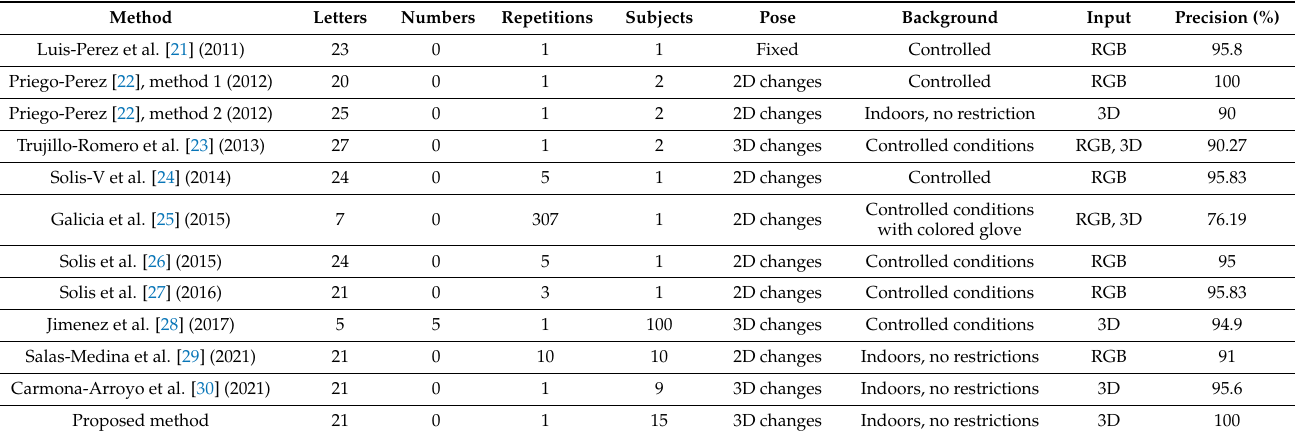
Table 2. Comparison of MSL recognition methods for static alphabet letters or